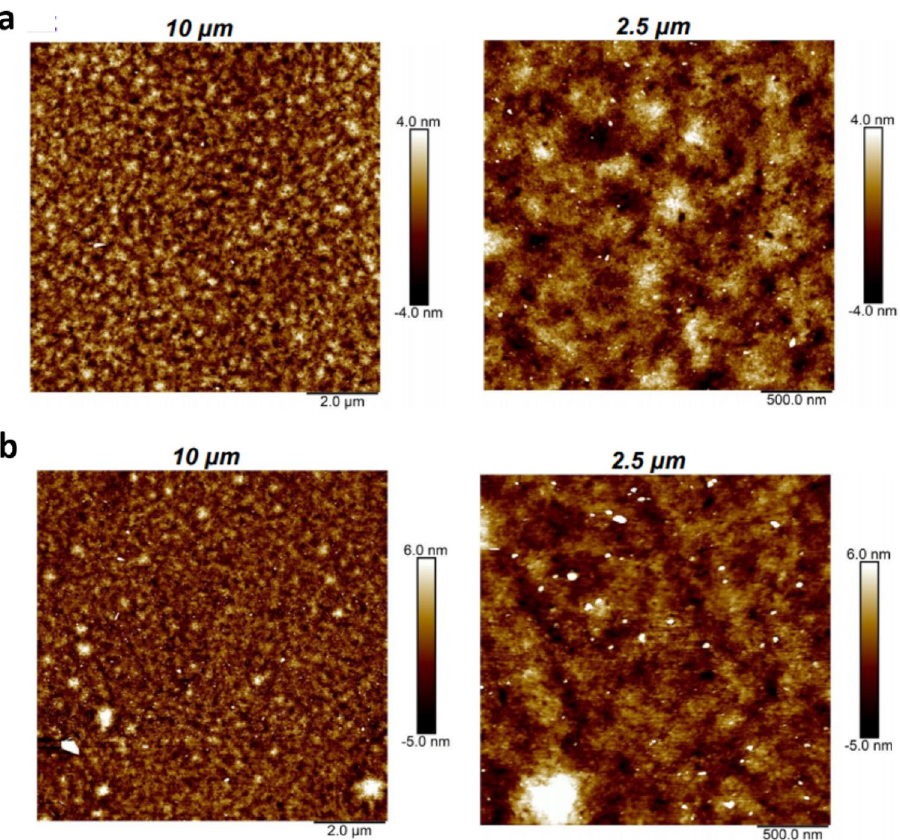
Figure 2. AFM height images of the PTB7:(3BS) 2 -SiPc films on two different scales (10 and 2.5 µm ( a ) before annealing and ( b ) after annealing (15 min at 100